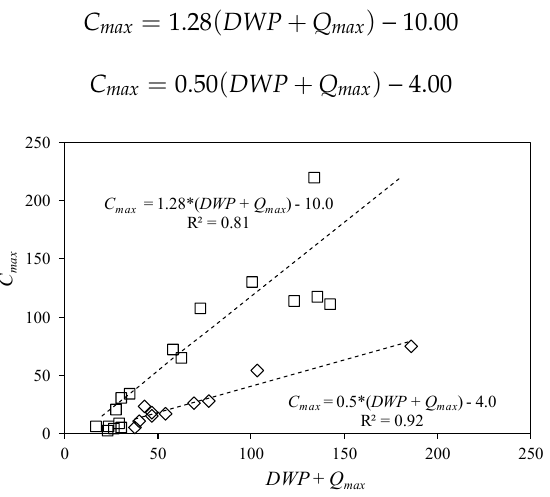
Figure 7. Adjustment of the maximum concentration ( C max ) parameter in the Garcia et al. [3,4] modified model.